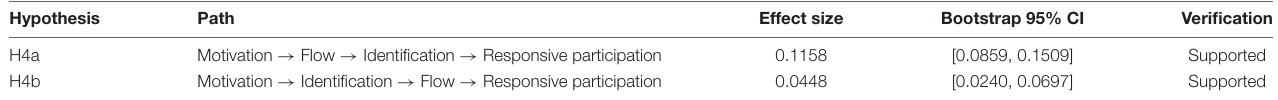
TABLE 5 | Verification of chain mediating